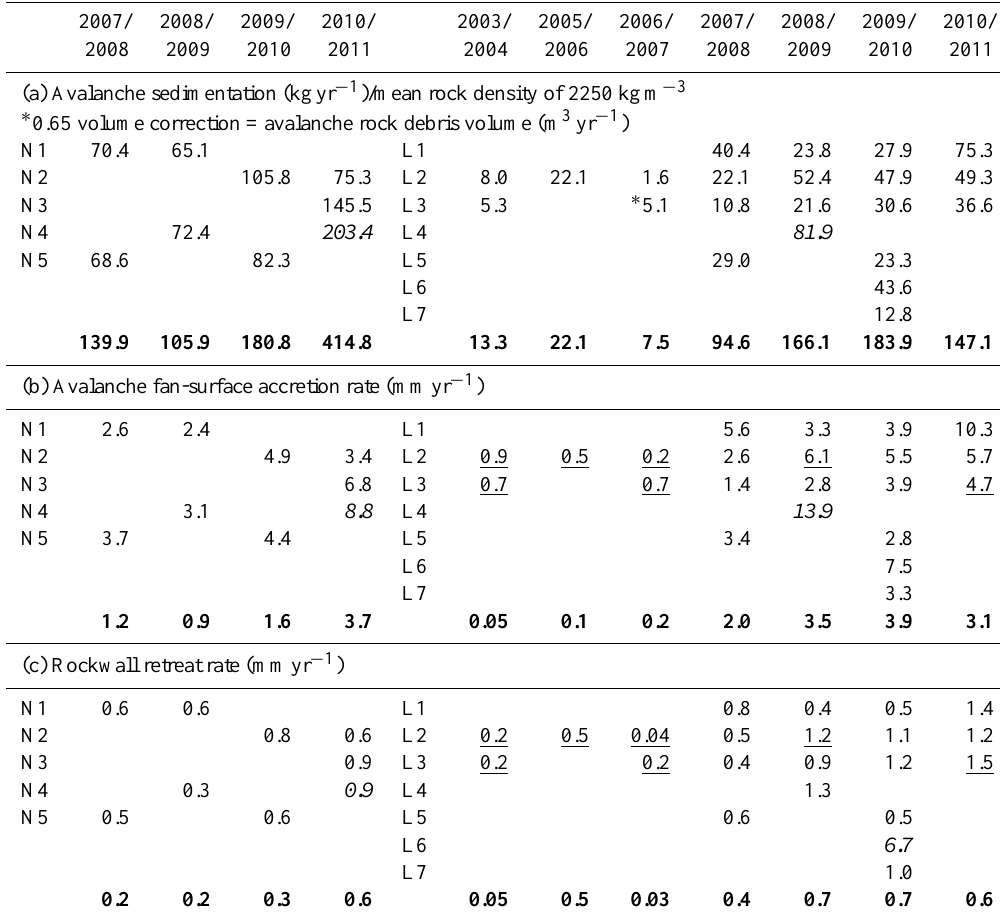
Table 2. Calculations of avalanche fan-surface accretion and rockwall retreat rates (mmyr − 1 ) for each catchment at the Nybyen (N1–N5) and Larsbreen (L1–L7) slope systems. The source and depositional areas for each catchment are visualized in Figs. 3 and 4 with the white outline and in Supplement Table 2. The annual averages for Nybyen and Larsbreen are given in bold. The highest values and rates for each calculation step are given in italic. The values and rates marked with an asterisk are from 2yr of observations. The underlined rates from Larsbreen are only calculated from permanent sediment